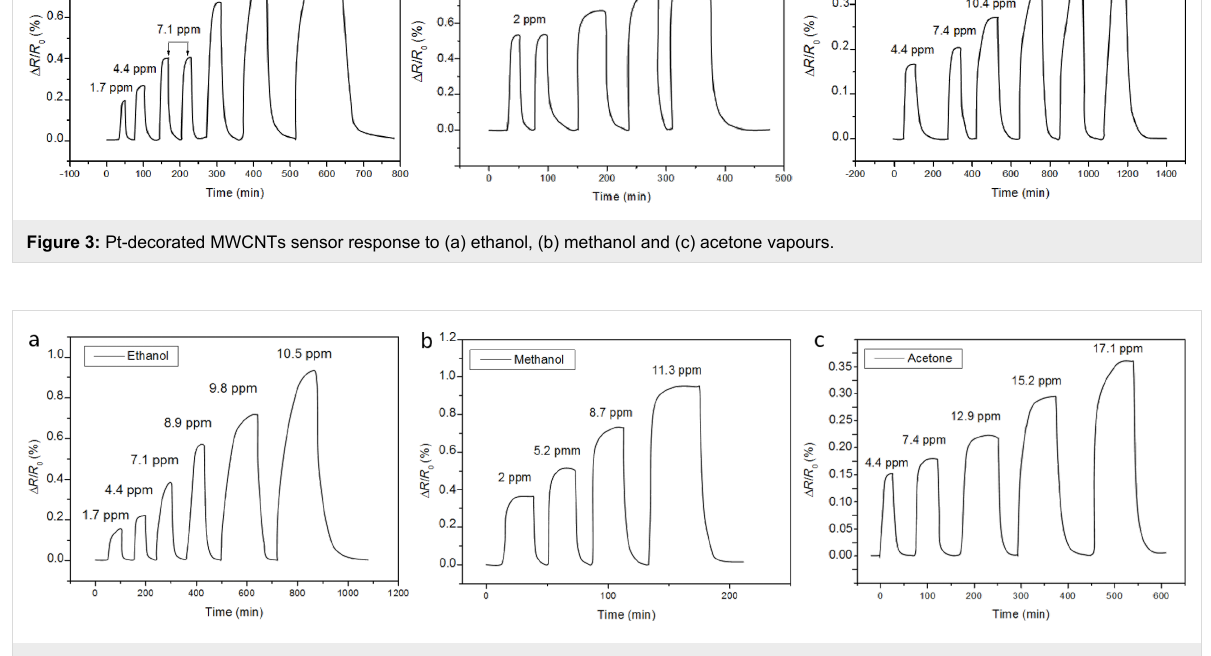
Figure 4: Pd-decorated MWCNTs sensor response to (a) ethanol, (b) methanol and (c) acetone